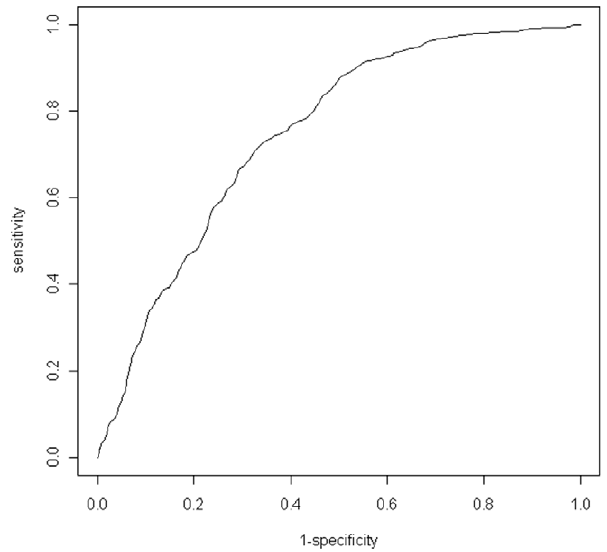
Figure 1. Receiver operating characteristics (ROC) curve for assessing goodness-of-fit for the top model selected from the candidate set. The area under the curve (AUC) is 0.76, suggesting a strong ability to discriminate between true and false signal and a good fit of the model to the data.